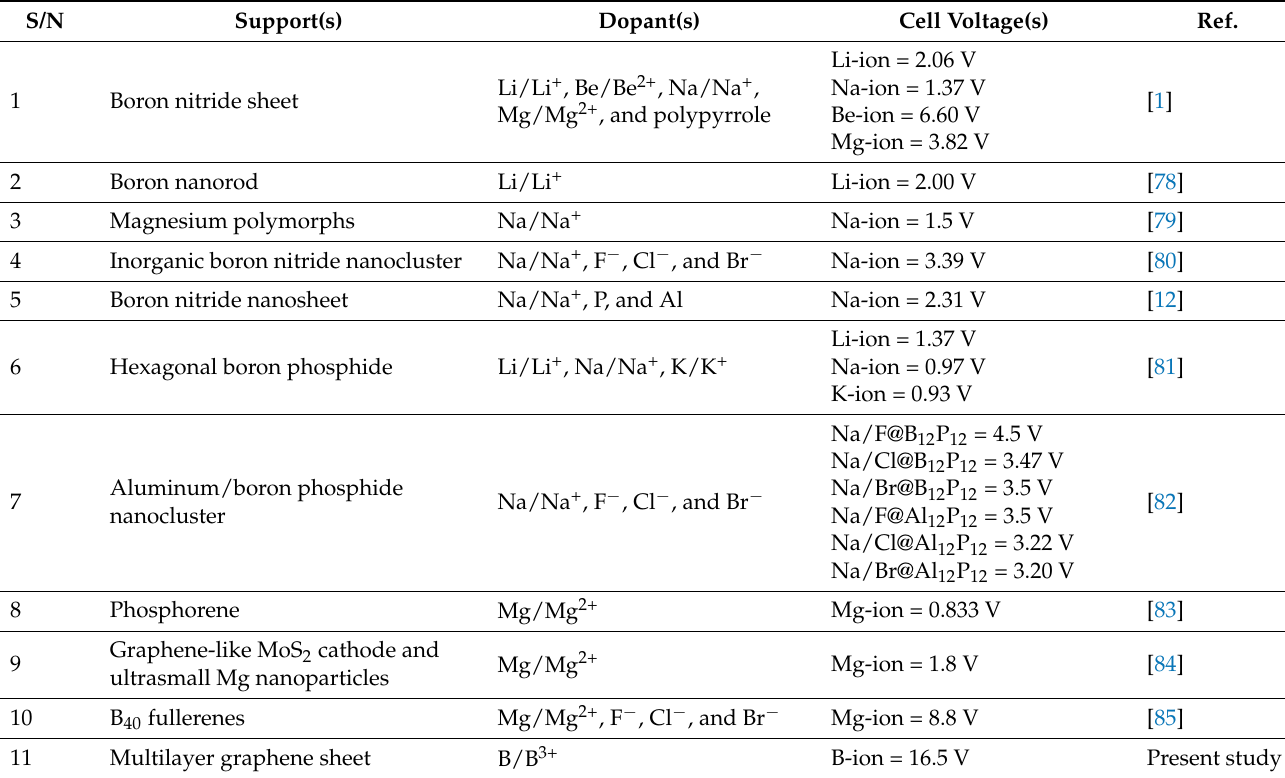
Table 3. Comparison of the present results with those reported in the